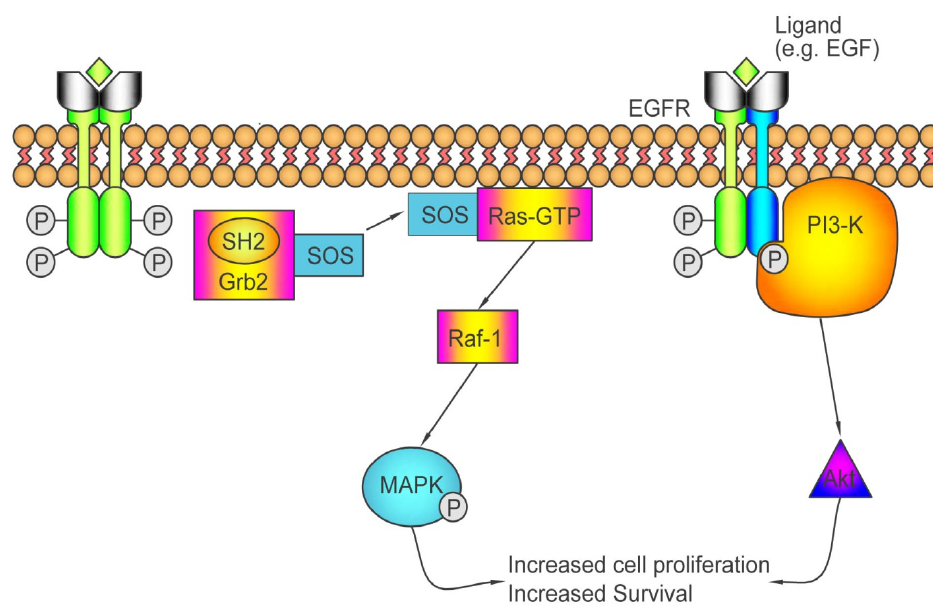
Figure 3. Activation of the EGFR pathway and the consequent engagement of the Ras/Raf/MAPK and PI3K/Akt